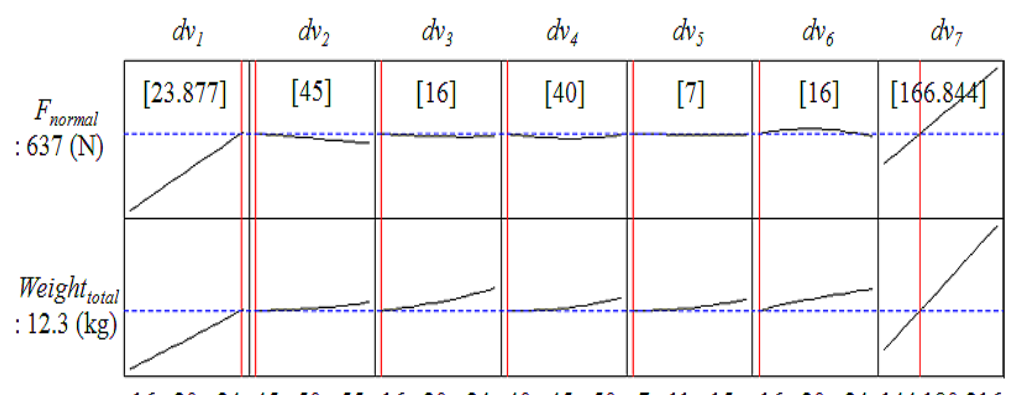
Figure 11. Response optimization.